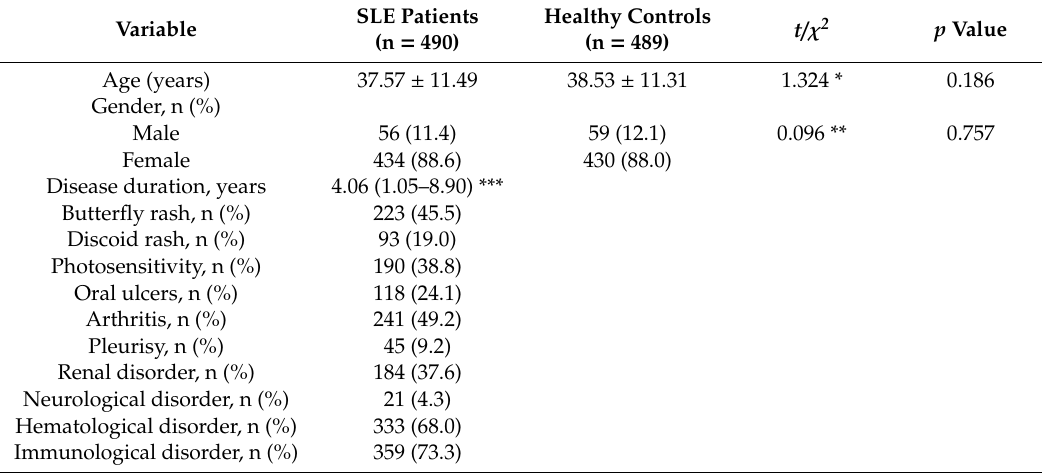
Table 2. Demographic characteristics and clinical features of